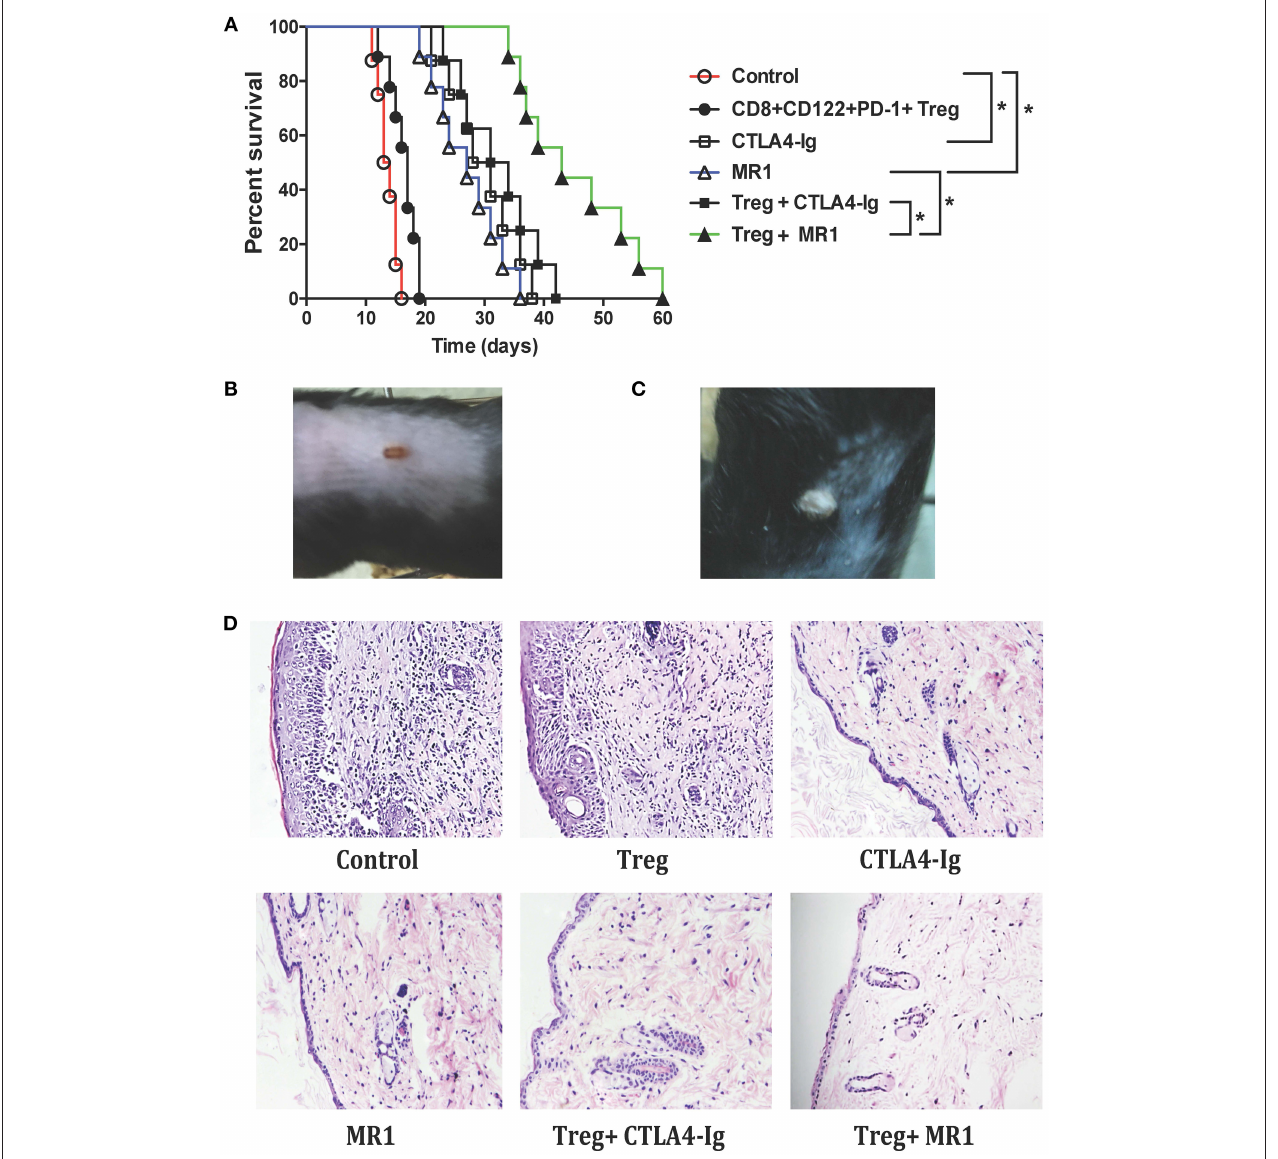
FIGURE 1 | Administration of CD8 + CD122 + PD-1 + Tregs synergizes with costimulatory blockade of CD40/CD154, but not B7/CD28, to suppress allograft rejection. C57BL/6 mice that received syngeneic CD8 + CD122 + PD-1 + Tregs were transplanted with BALB/c skin and then treated with either MR1 (anti-CD154 Ab) or CTLA4-Ig, as described in the methods. Skin allograft rejection was observed ( n = 8–9) (A) . A representative of rejected (B) and accepted (C) skin grafts was shown. H&E staining was also performed to evaluate cellular infiltration in skin grafts 2 weeks after skin transplantation. One set of images from three separate experiments is shown (D) . * P <